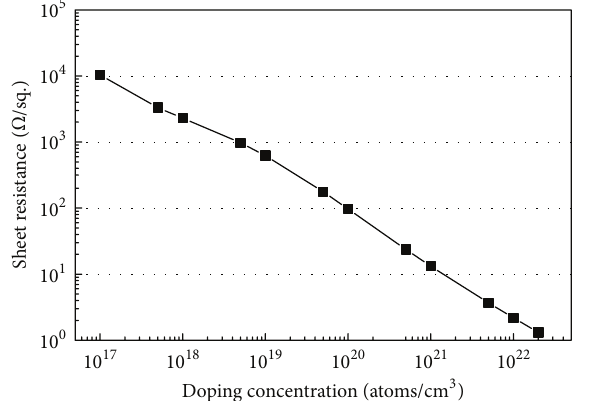
Figure 5: Dependence of the sheet resistance on the doping concen- tration of